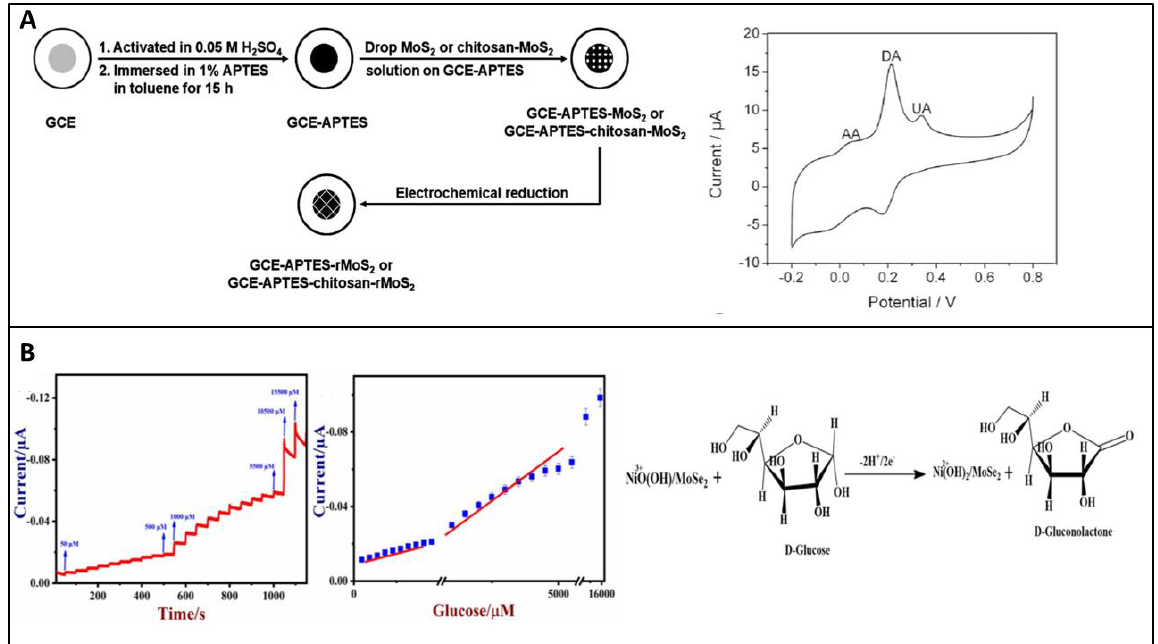
Figure 9. ( A ) Steps involved in the preparation of electrochemically rMoS 2 and chitosan modified MoS 2 electrodes and its CV curve in 0.1 M PBS. (Source: Reprinted with permission from Ref [100] Small 2012, 8, 2264 – 2270, doi:10.1002/smll.201200044. from Elsevier) ( B ) Amperometric curve NiO/MoSe 2 /GCE with the successive additions of glucose and its oxidation mechanism. (Source: Reprinted with permission from Ref [101] Scientific Reports Available online: https://www.nature.com/articles/s41598-021-92620-2 (accessed on 24 April 2022) from Elsevier).